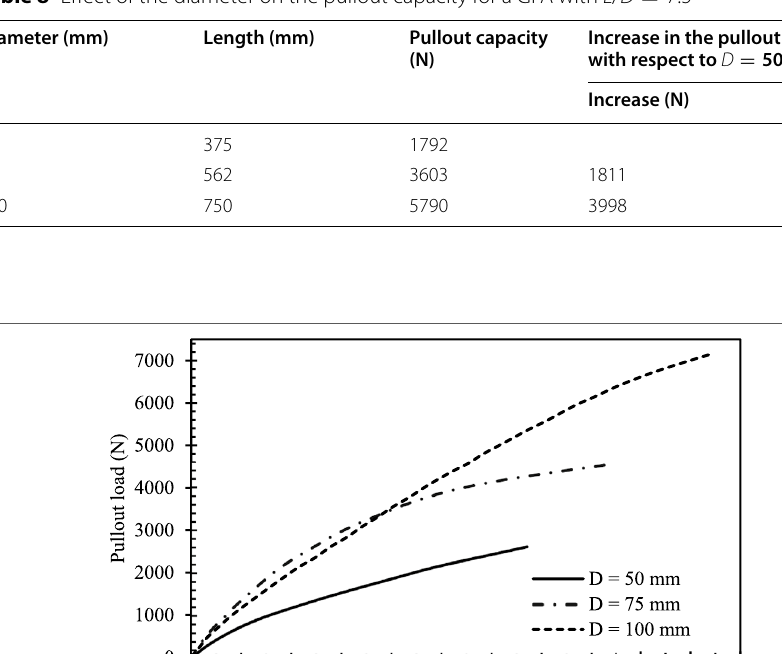
Table 8 Effect of the diameter on the pullout capacity for a GPA with L / D